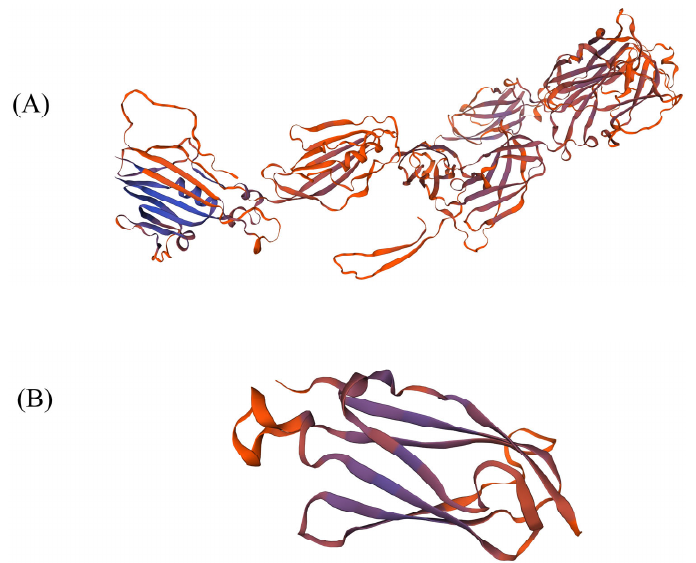
Figure 6. Tertiary structure of filamin proteins in upland cotton. ( A ) Tertiary structure of GEX2 subgroup protein in upland cotton. ( B ) Tertiary structure of FLMN subgroup protein in upland cotton.